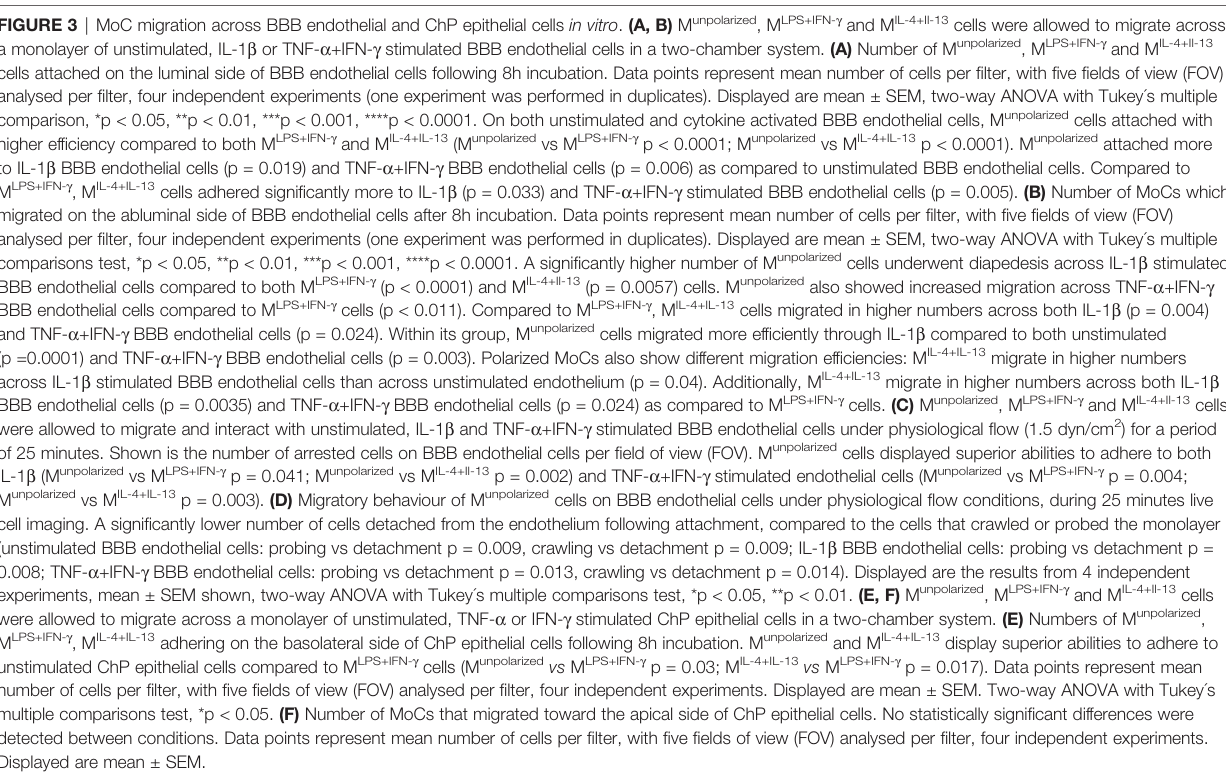
FIGURE 3 | MoC migration across BBB endothelial and ChP epithelial cells in vitro . (A, B) M unpolarized , M LPS+IFN- g and M IL-4+Il-13 cells were allowed to migrate across a monolayer of unstimulated, IL-1 b or TNF- a +IFN- g stimulated BBB endothelial cells in a two-chamber system. (A) Number of M unpolarized , M LPS+IFN- g and M IL-4+Il-13 cells attached on the luminal side of BBB endothelial cells following 8h incubation. Data points represent mean number of cells per fi lter, with fi ve fi elds of view (FOV) analysed per fi lter, four independent experiments (one experiment was performed in duplicates). Displayed are mean ± SEM, two-way ANOVA with Tukey´s multiple comparison, *p < 0.05, **p < 0.01, ***p < 0.001, ****p < 0.0001. On both unstimulated and cytokine activated BBB endothelial cells, M unpolarized cells attached with higher ef fi ciency compared to both M LPS+IFN- g and M IL-4+IL-13 (M unpolarized vs M LPS+IFN- g p < 0.0001; M unpolarized vs M IL-4+IL-13 p < 0.0001). M unpolarized attached